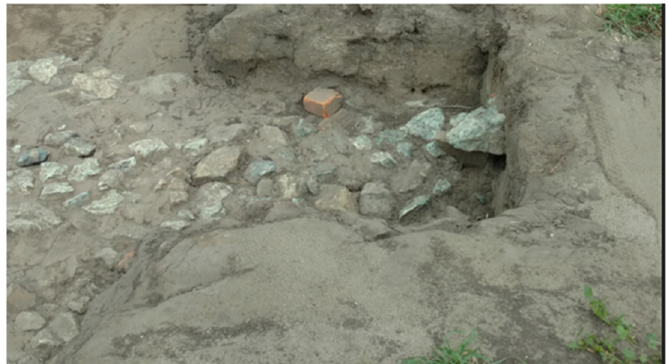
Figure 23. Excavated foundation feature at Presidio San Francisco identified in 2017 GPR survey. The GPR grid was adjacent to this excavation, to the right of this image, showing indications of a continued wall foundation to the north of the excavation.